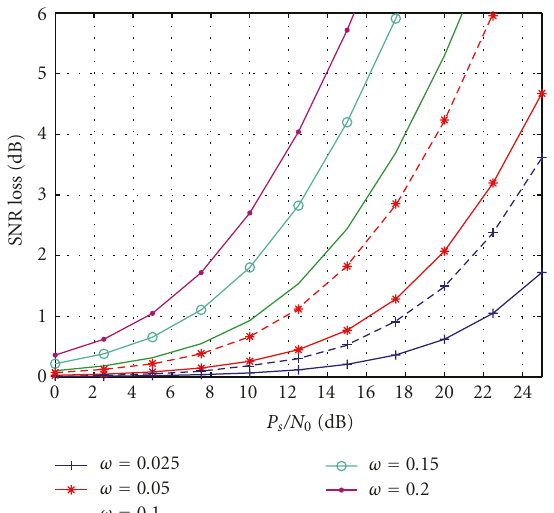
Figure 6: SNR loss after CFO compensation versus SNR for CFOs of di ff erent size ω . Solid line: ICI compensation. Dashed line: no compensation. μ = 1, Q = 2, N/L =